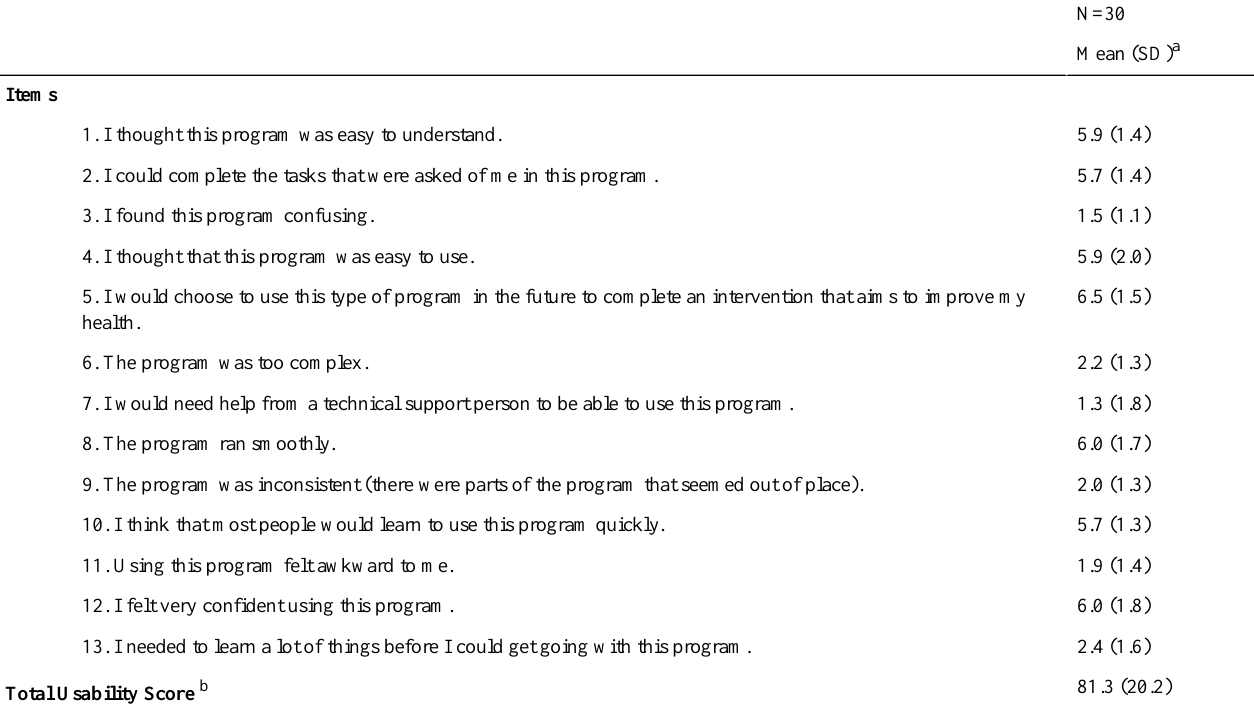
Table 3. Usability evaluation of health planner by end user